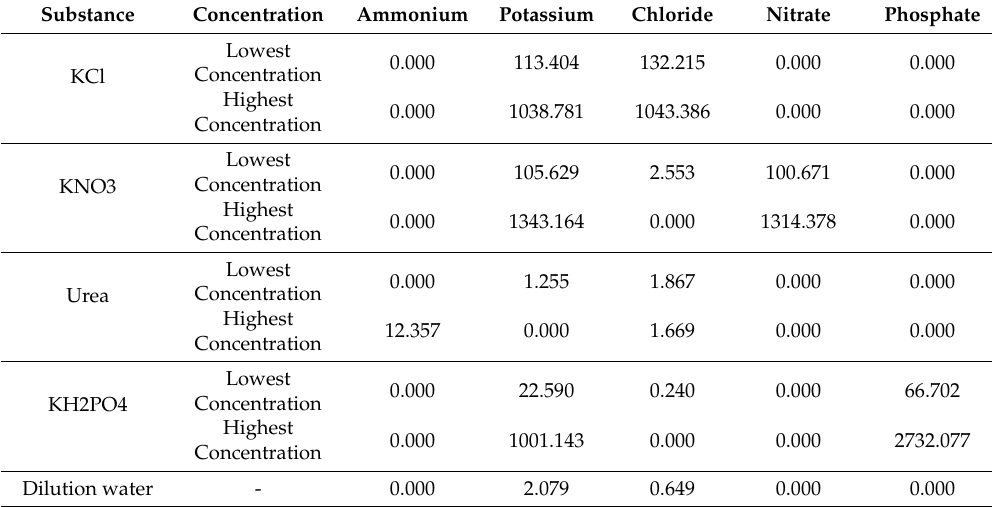
Table 1. Ion chromatography of the dilutions from the chemical reagents (units: mg · L − 1 ).